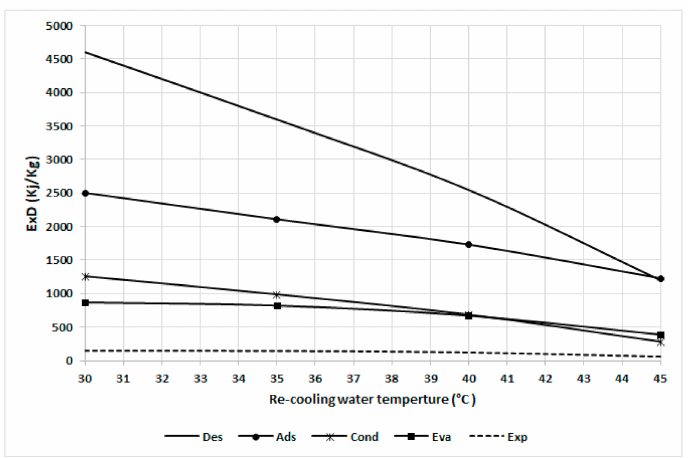
Figure 10. Exergy destruction in the chiller components at various recooling-water temperatures. To separately investigate the effect of the recooling-water temperature on the ex- ergy destruction, the dead state temperature is assumed constant at 25 ◦ C regardless of the recooling-water temperature, and the result is compared to the variable dead state temperature (dead state temperature is assumed to be 5 ◦ C less than the recooling-water temperature). Figure 11a,b show the total exergy destruction and exergetic efficiency, respectively. It can be noted that the exergy destruction decreases with increasing recooling- water temperature for fixed and variable dead state temperature. As shown in Figure 11a, it is clear that the total exergy destruction decreases with an increasing dead state tem- perature. The exergetic efficiency curves of Figure 11b show that the fixed dead state temperature exhibits the opposite trend compared to the variable dead state temperature.